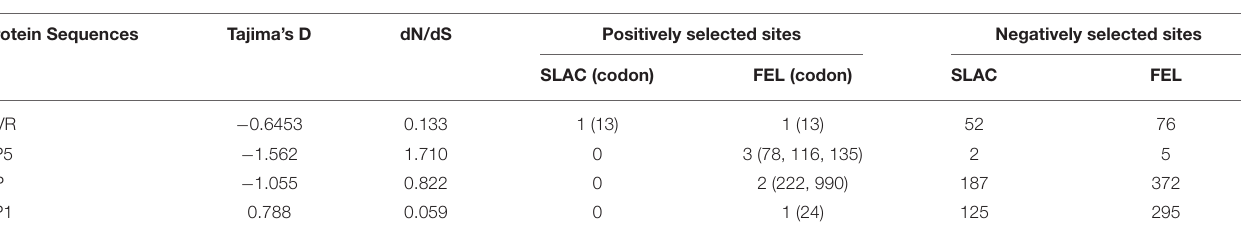
TABLE 6 | Codon selection pressures on IBDV sequences used in the study. Protein